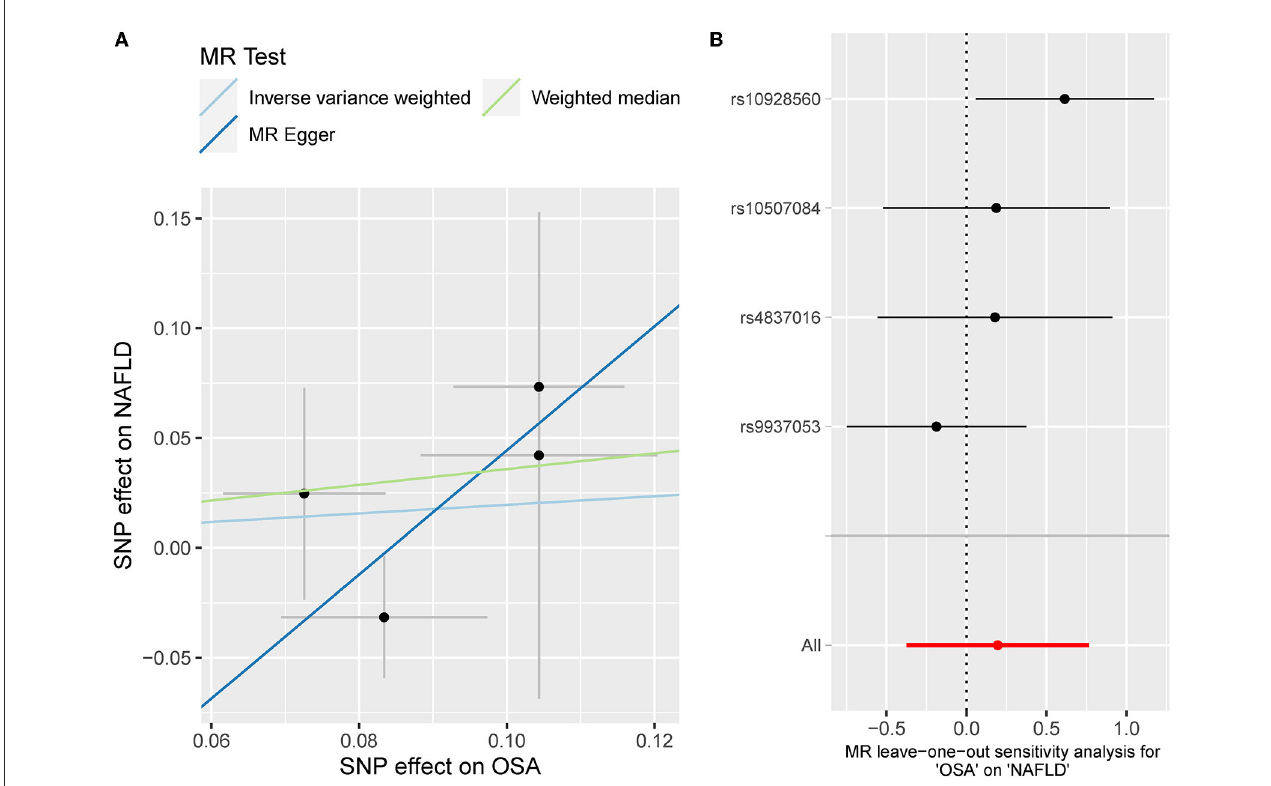
FIGURE4 (A) The scatterplot of OSA-NAFLD results. Different colors represent different methods and each point is a single nucleotide polymorphism. The horizontal and vertical lines of each point represent the 95% confidence interval of the effect size. (B) The leave-one-out-sensitivity forest plot of OSA-NAFLD